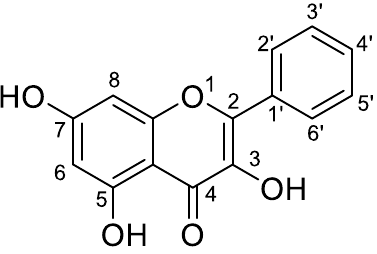
Figure 1. Chemical structure of galangin.